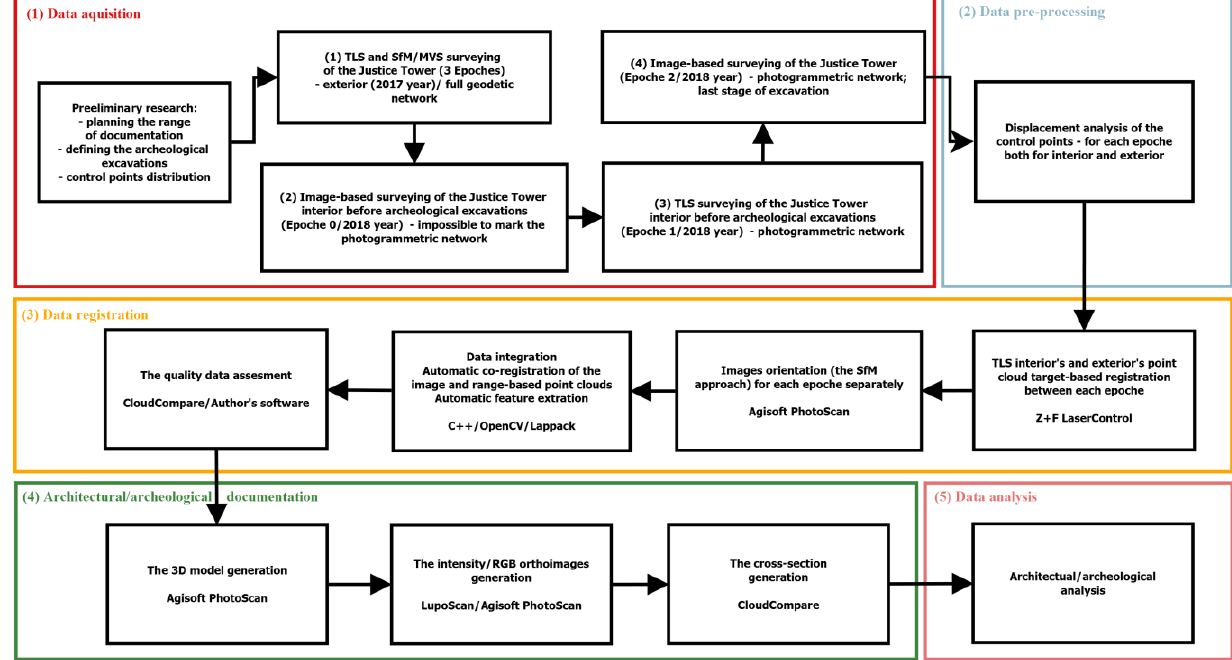
Figure 1. The block diagram of the performed